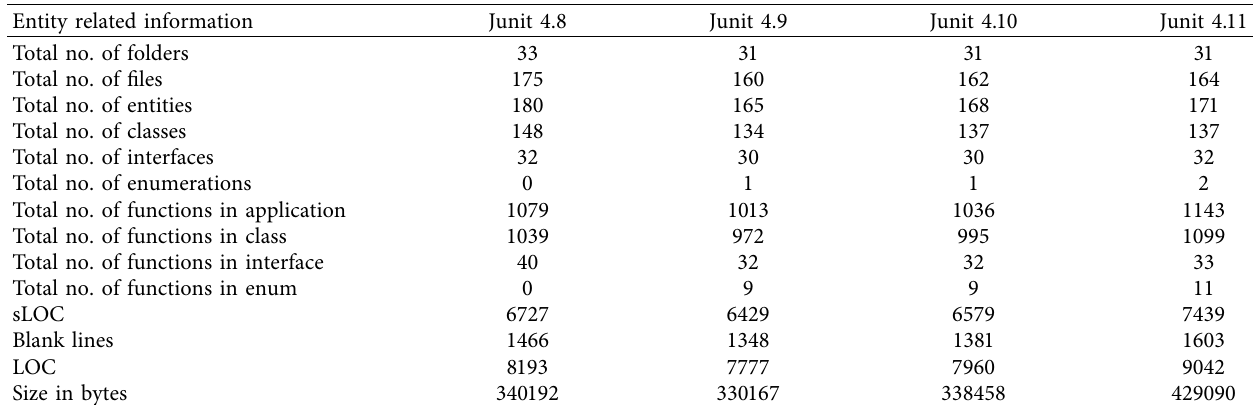
Table 3: Facts about entities in Junit dataset.